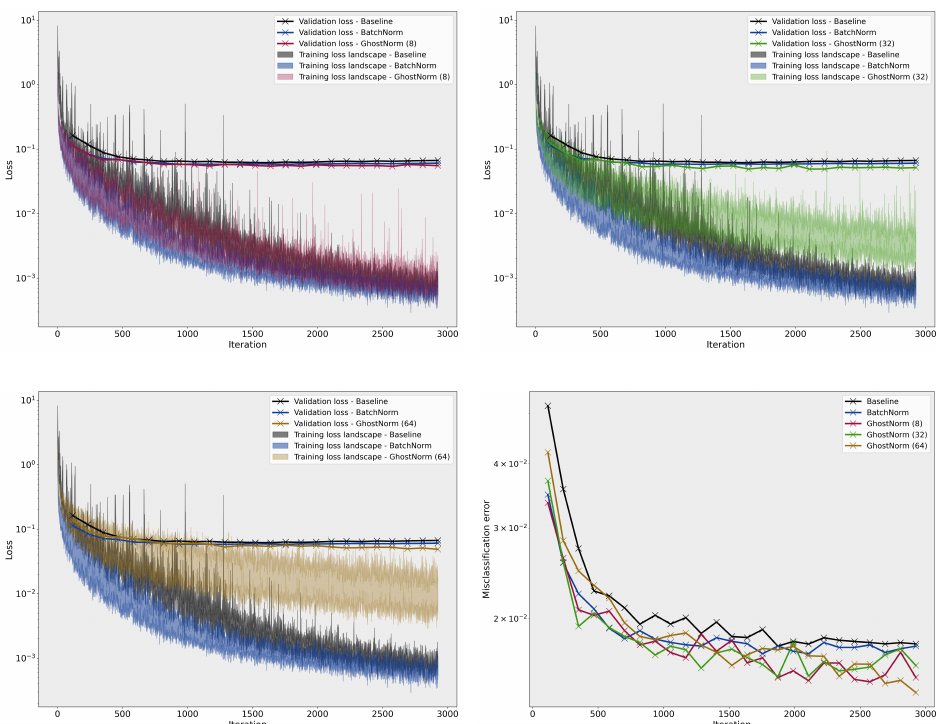
Figure A3. Comparison of the loss landscape on MNIST between the baseline, BatchNorm, and GhostNorm with different G M values. The last figure (bottom right) depicts the misclassification error on the testing set during training.